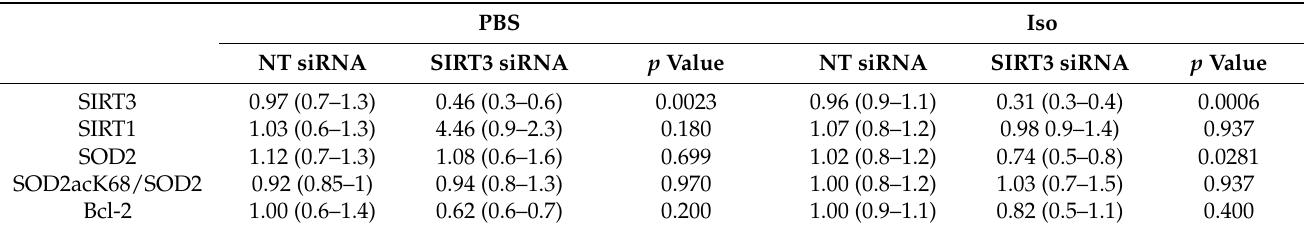
Figure 2. Effect of SIRT3 inhibition on SOD2 activation and mitochondrial oxidative stress in control and hypertrophied neonatal rat cardiomyocytes (NCMs). Control (PBS) or Iso-treated NCM were transfected without (gray box) or with (light blue box) SIRT3 siRNA for 72 h. Quantification by Western blot of SIRT3 and SIRT1 expression ( a ) and of SOD2acK68/SOD2 ratio and SOD2 expression ( b ) in Iso-treated NCM transfected with control or SIRT3 siRNA. Data were normalized on actin. ( c ) Mitochondrial superoxide anions production was detected after MitoSOX (red) and nuclei (blue) staining and quantified from 3 independent experiments and at least 92 cells. ( d ) Cell area was quantified from 3 independent experiments and at least 108 cells after alpha-actinin (red) and nucleus (blue) staining. Scale bar = 20 µm. Only significant p values are indicated from 3 independent experiments. Images were selected to represent the mean values of each condition. Table 1. Quantification of the effect of SIRT3 inhibition on sirtuins and SOD2 activation in control and hypertrophied neonatal rat cardiomyocytes (NCMs) by Western